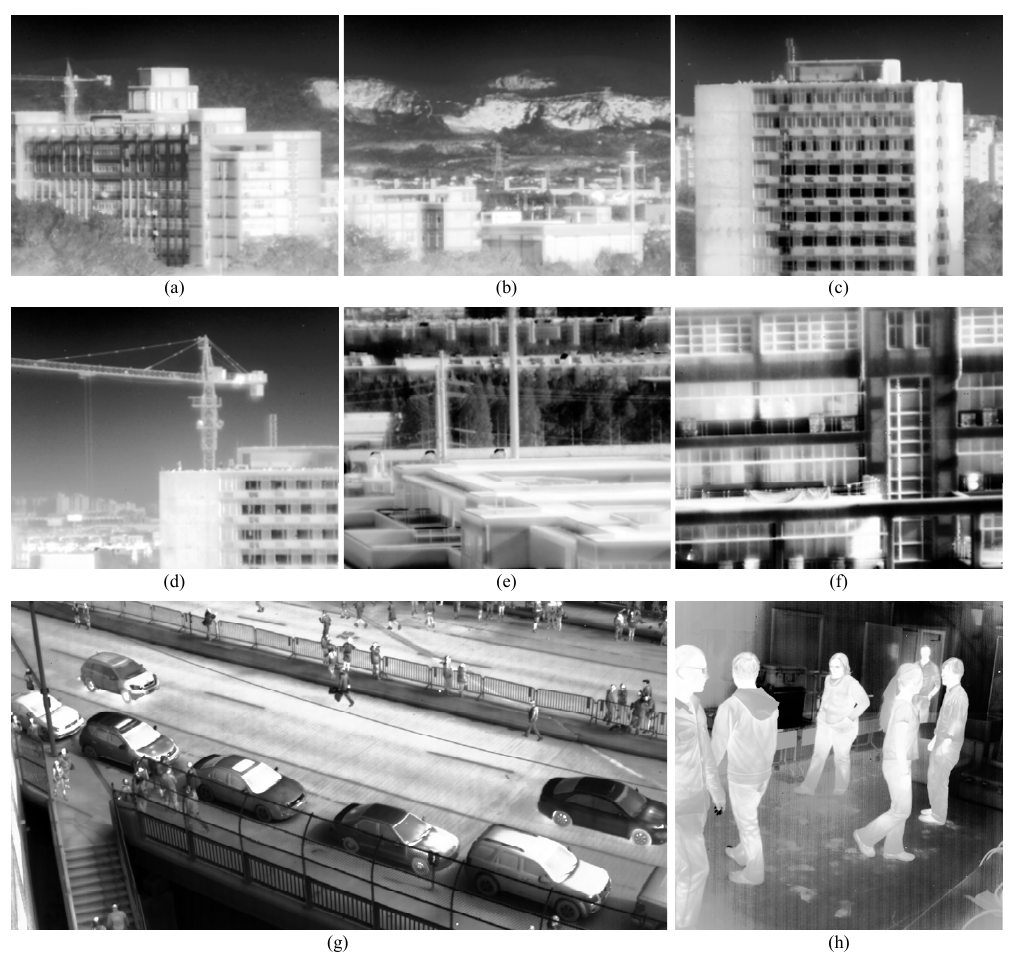
Figure 6. The HE results of the six infrared images used in the experiments. ( a ) Building1, ( b ) Hills, ( c ) Building2, ( d ) Sky, ( e ) Trees, ( f ) Windows, ( g ) Road, ( h ) Students.